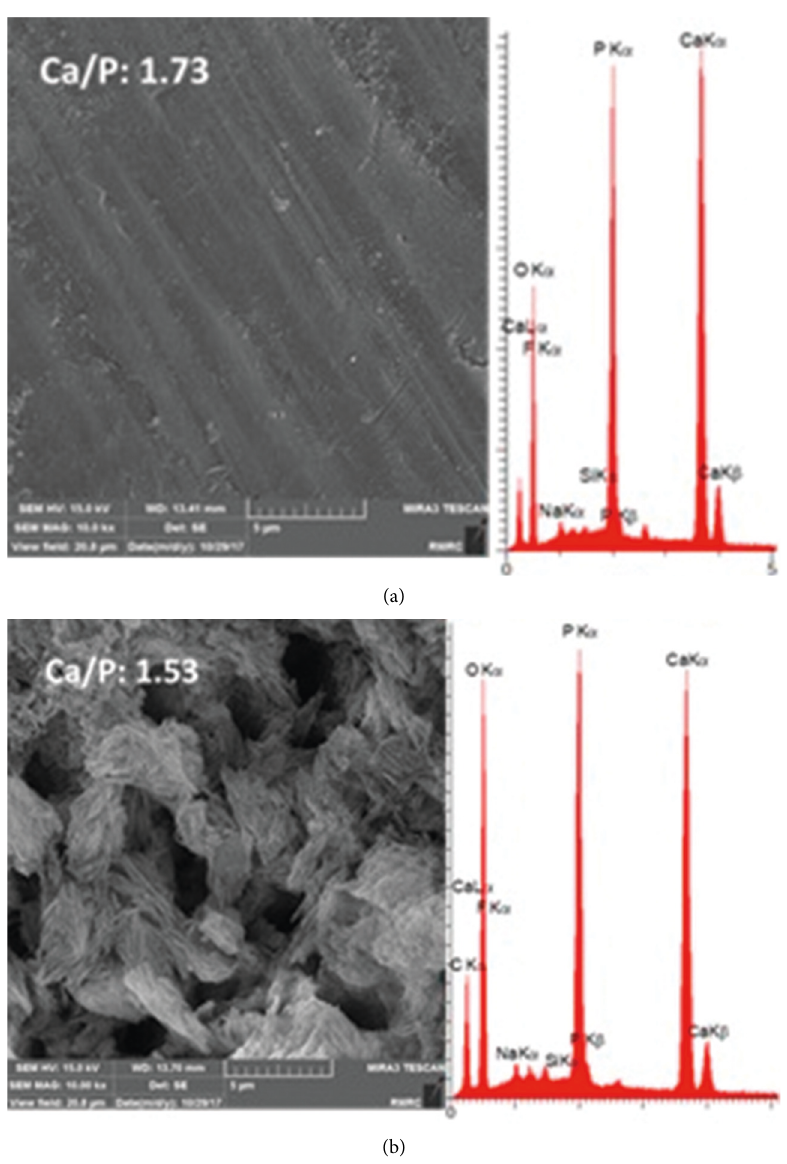
Figure 6: FESEM/EDS analyses of sound and demineralized